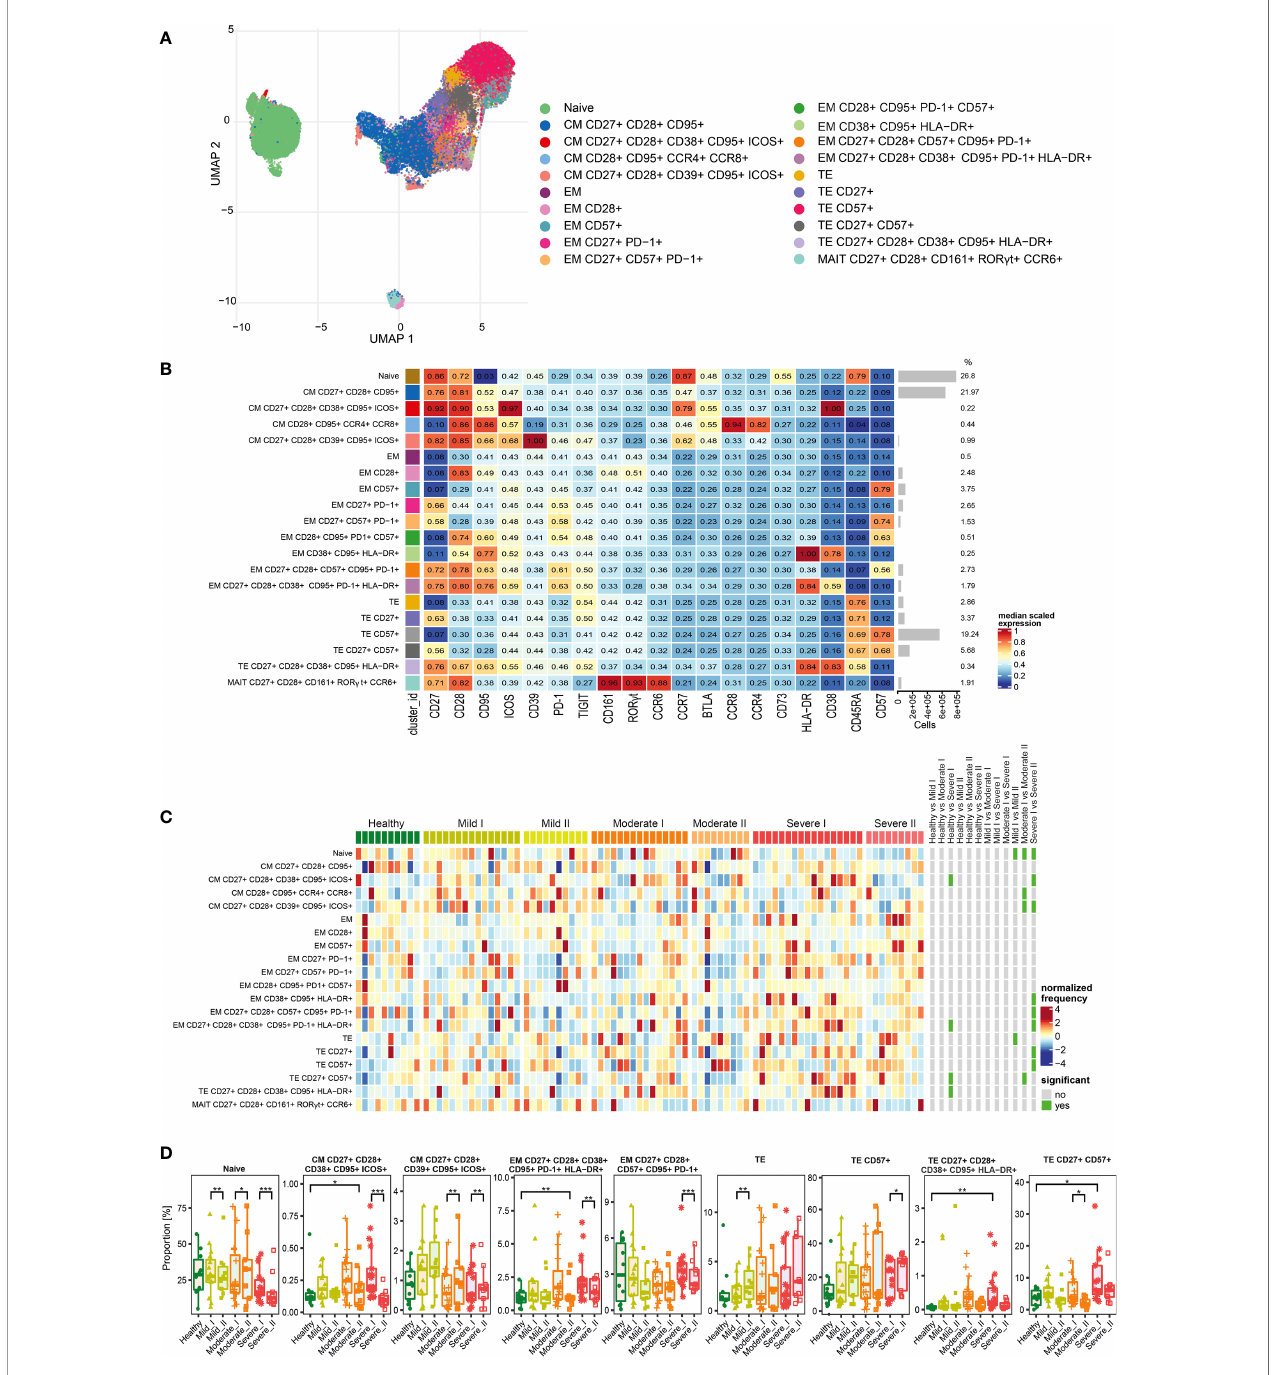
FIGURE 5 | Unsupervised analysis of CD8+ T cells and their characterization. (A) Uniform Manifold Approximation and Projection (UMAP) UMAP representation of CD8+ T cell landscape. (B) Heat map representing different clusters identi fi ed by FlowSOM, with relative identity and percentages in healthy controls and convalescent patients. The color in the heat map represents the median of the arcsinh, 0 – 1 transformed marker expression calculated over cells from all the samples, varying from blue for lower expression to red for higher expression. Each cluster has a unique color assigned (bar on the left). Barplots along the rows (clusters) and values on the right indicate the relative sizes of clusters. (C) Differential analysis of all severity groups of COVID-19 convalescent patients (mild, moderate, severe), as well as healthy donors at the time points I and II. The heat represents arcsine-square-root transformed cell frequencies that were subsequently normalized per cluster (rows) to mean zero and standard deviation of one. The color of the heat varies from dark blue indicating relative under- representation to red indicating relative over-representation. Bars at the right indicate signi fi cantly differentially abundant clusters (green). (D) Differential proportion of selected clusters presented as % of CD8+ cells. *p ≤ 0,05; ** p ≤ 0,01; *** p ≤